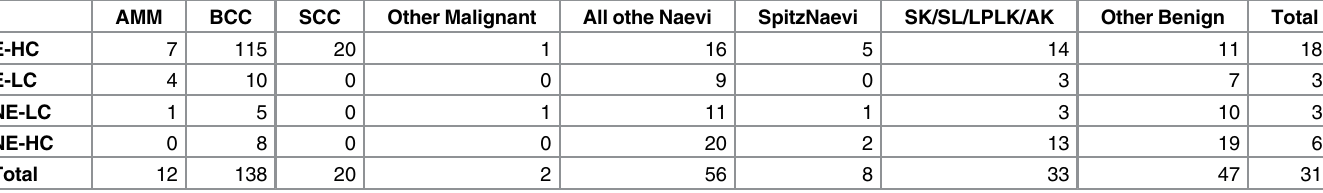
Table 3. Confidence level frequencies (Reader 2 dermoscopy-RCM imaging).